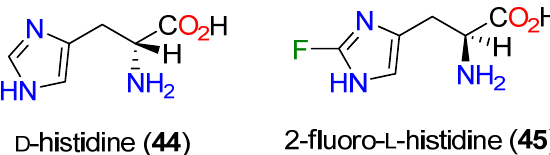
Figure 11. Structures of D-histidine ( 44 ) and 2-fluoro-L-histidine ( 45 ).